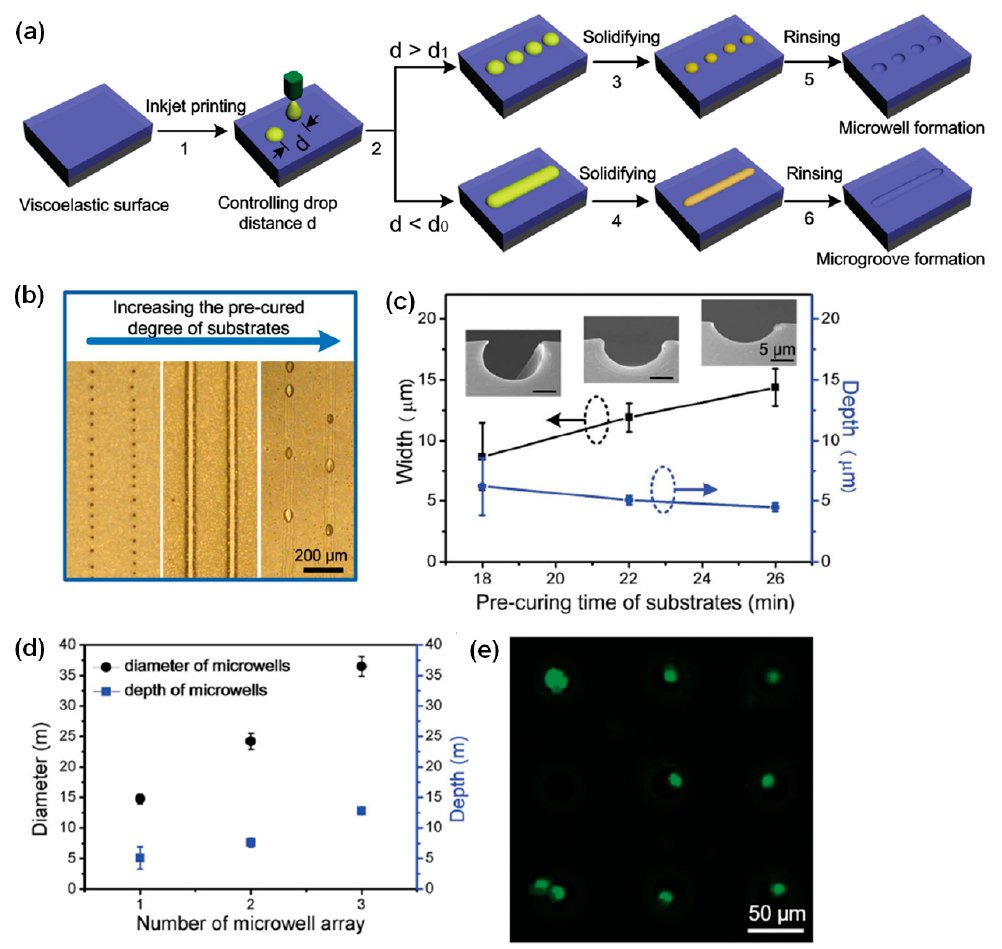
Figure 4. ( a ) The inkjet etching of concave microstructures; ( b ) Optical microscopy images of PDMS films with various degrees of pre-curing after etching with poly acrylic acid (PAA) solution; ( c ) Line width and depth of microgrooves as functions of the polydimethylsiloxane (PDMS) film pre-curing time. The insets show images of the fabricated microgrooves (The scale bars in Figure 4c are 5 µ m); ( d ) The dimensions of the microwells used in the trapping of cells; ( e ) Fluorescence image of the microwells with trapped single cells [44]. Copyright 2015 Wiley.